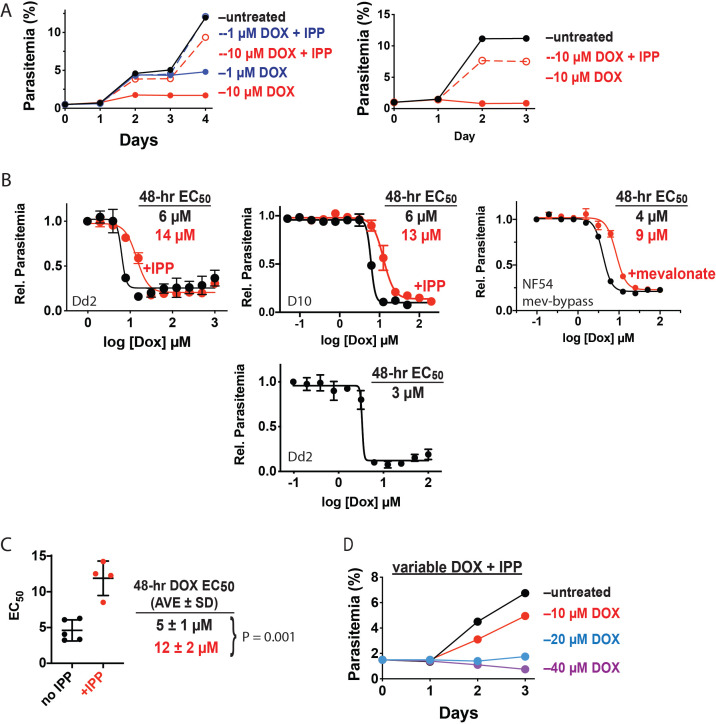
Additional, independent growth assays with DOX and IPP.(A) Additional continuous growth assays of synchronized Dd2 parasites treated with 1 or 10 µM DOX ±200 µM IPP. (B) Independent 48 hr growth-inhibition assays for DOX-treated Dd2, D10, NF54 parasites in the absence or presence of 200 µM IPP or 50 µM mevalonate. Dd2 and NF54 parasites were synchronized by single treatment with 5% D-sorbitol. D10 parasites were synchronized by magnet purification of schizonts followed by 5 hr incubation with uninfected erythrocytes and treatment with 5% D-sorbitol. Data points in individual plots are the ave ± SD of two to four biological replicates. Each plot reflects an independent assay performed with a different batch of blood. (C) Scatter plot of doxycycline EC50 values from independent assays ± IPP with calculated ave ± SD and analysis by two-tailed unpaired t-test. (D) Independent continuous growth assay of synchronized Dd2 parasites treated with 10–40 µM DOX and 200 µM IPP.